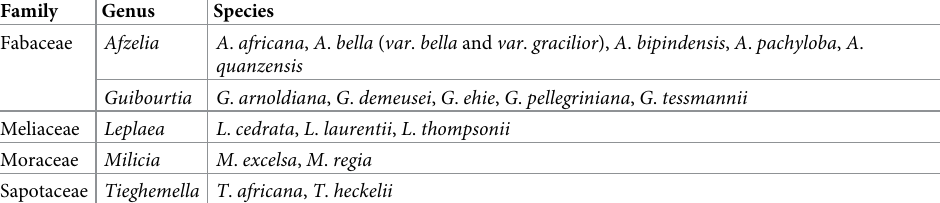
Table 1. Commercial African timber species analyzed in this